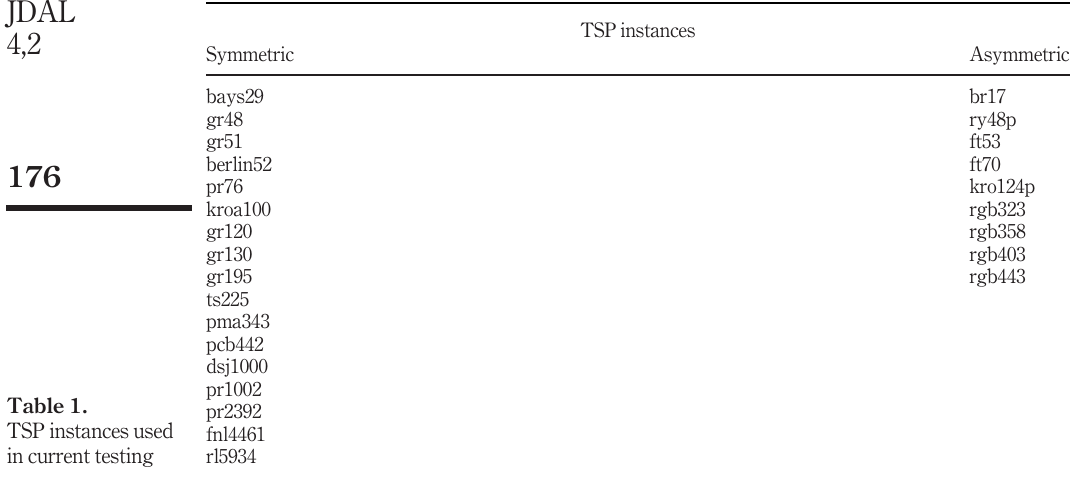
Table 1. TSP instances used in current